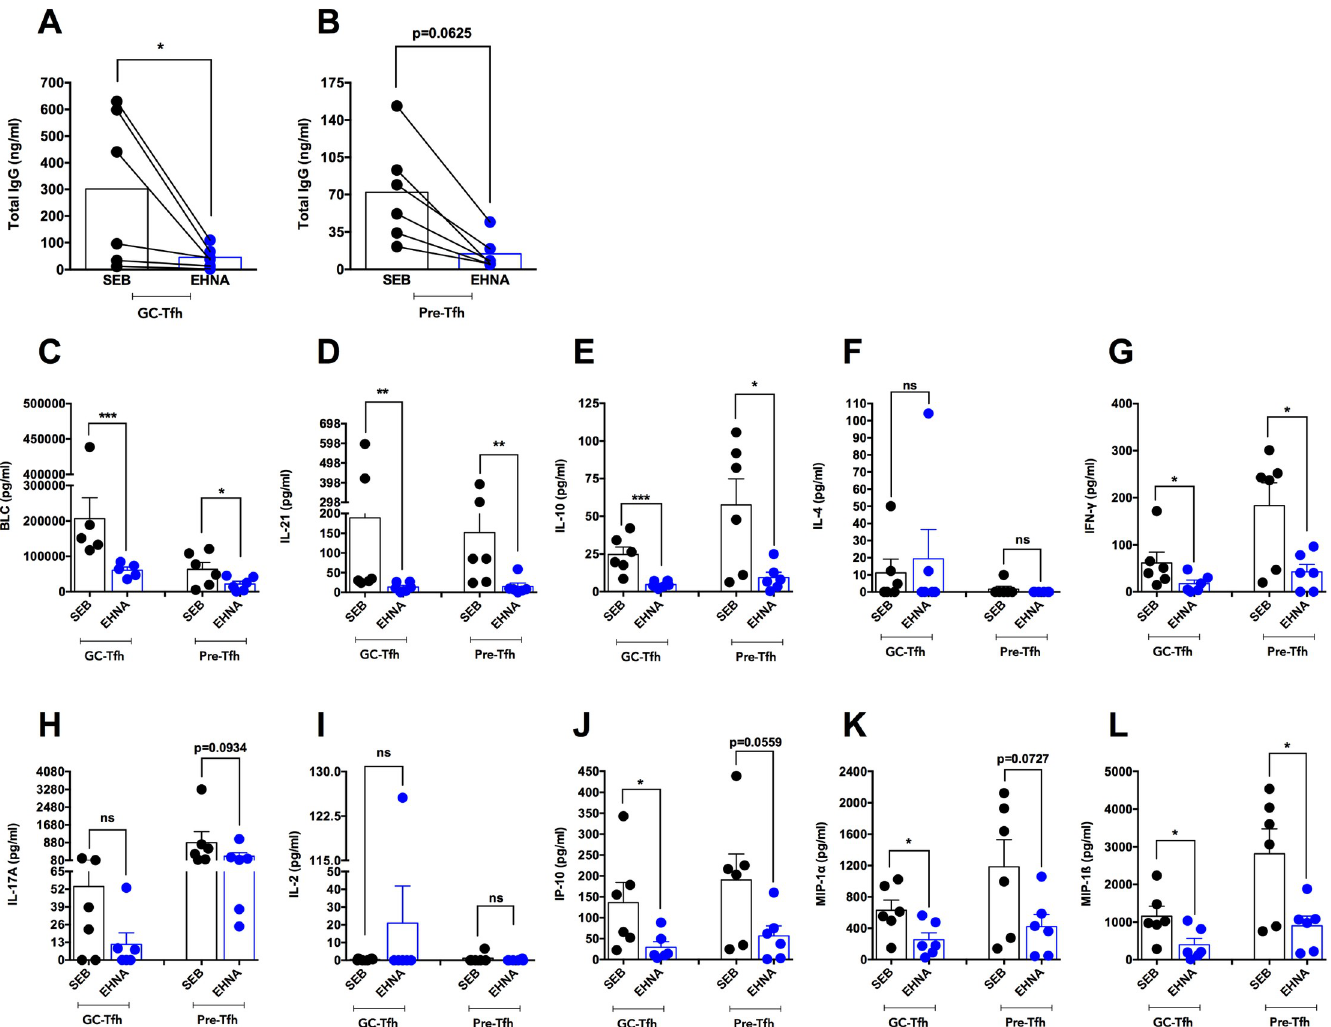
Fig 7. Specific ADA-1 blockade attenuates healthy tonsillar GC-Tfh cell function. We sorted GC-Tfh, pre-Tfh and autologous GC-B cells from the tonsils of healthy individuals and co-cultured GC-Tfh:GC-B as well as pre-Tfh:GC-B cells in a 1:1 ratio in the presence of SEB (SEB) with or without 10uM of the specific ADA-1 inhibitor EHNA (EHNA). (A-B) We collected culture supernatants 5 days after co-culture and analyzed the levels of total IgG in ng/ml by ELISA. (A) Total IgG level in supernatant from GC-Tfh:GC-B cell co-cultures. (B) Total IgG level in supernatant from pre-Tfh:GC-B cell co-cultures. Results are from 2 independent experiments (n = 6) and are represented as mean as well as before and after treatment lines. Data was analyzed with the two-tailed paired non-parametric Student’s t- test using the Wilcoxon matched-pairs signed rank test. (C-L) We collected culture supernatants 5 days after co-culture and analyzed GC-Tfh and pre-Tfh cell cytokine and chemokine levels by the Luminex assay. Levels of (C) BLC, (D) IL-21, (E) IL-10, (F) IL-4, (G) IFN- γ , (H) IL-17A, (I) IL-2, (J) IP-10, (K) MIP-1 α and (L) MIP-1ß are shown in pg/ml. Results are from 2 independent experiments (n = 6) and are represented as mean ± SEM. Data was analyzed with the two-tailed unpaired non- parametric Student’s t-test using the Mann-Whitney test. Nominal p-values p < 0.05 were considered statistically significant. � p < 0.05, �� p < 0.01 and ��� p < 0.001.